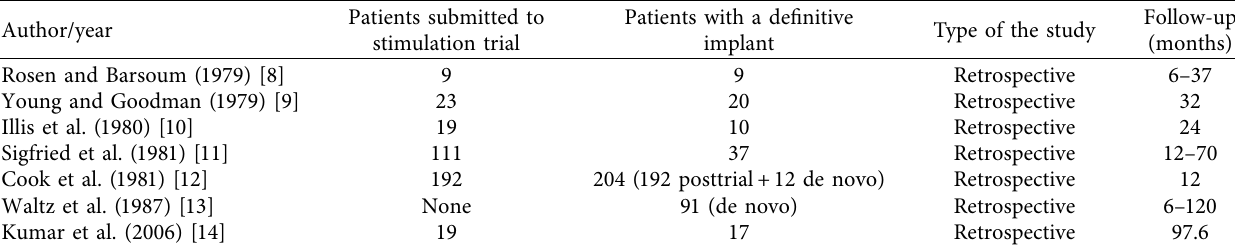
Figure 1: Flowchart of study selection. Table 1: Studies included in the pooled statistical